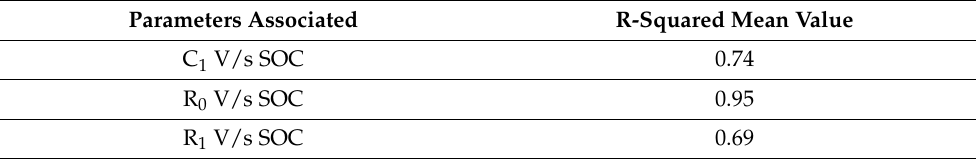
Table 3. R-squared mean value for parameter estimation.